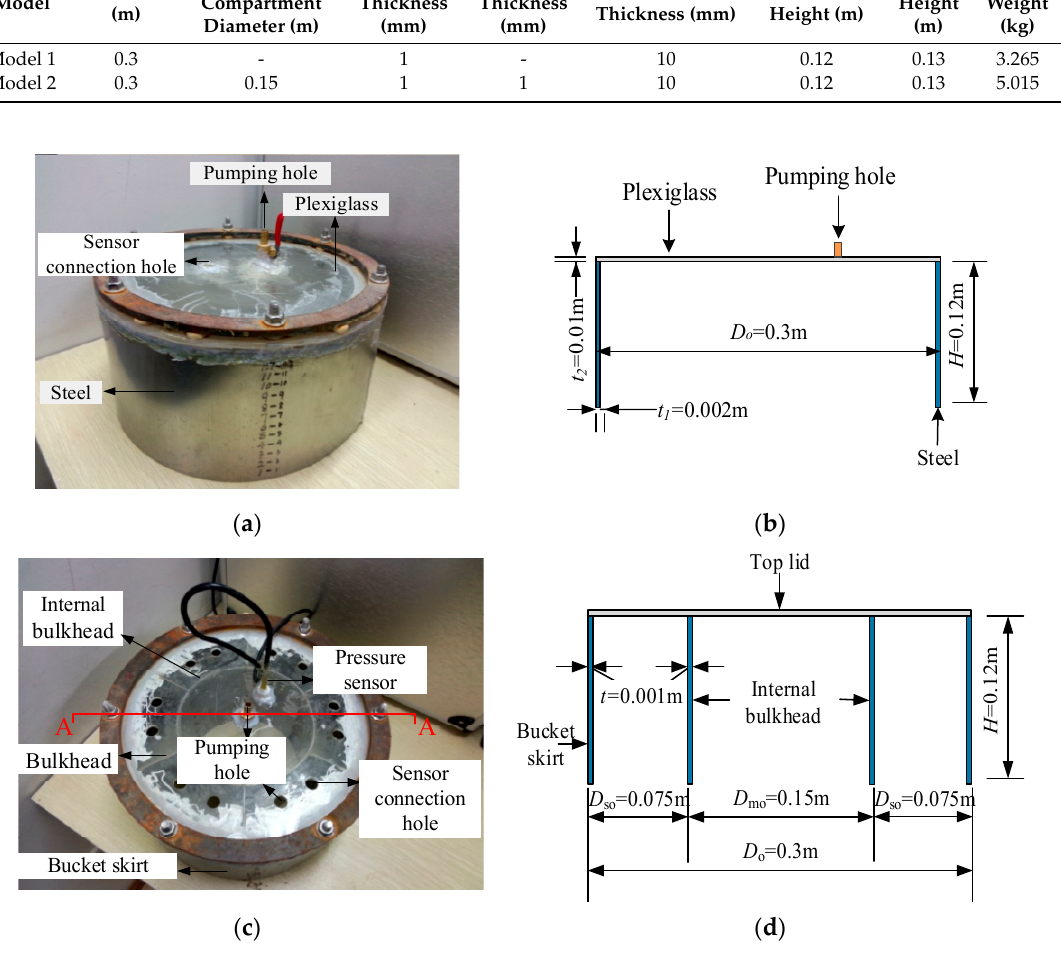
Figure 2. Schematic diagram of test model in sand. ( a ) Mono-compartment bucket foundation model; ( b ) Schematic diagram of the mono-compartment bucket foundation; ( c ) Mono-bucket multi-compartment foundation model; ( d ) Schematic diagram of the mono-bucket multi-compartment foundation.